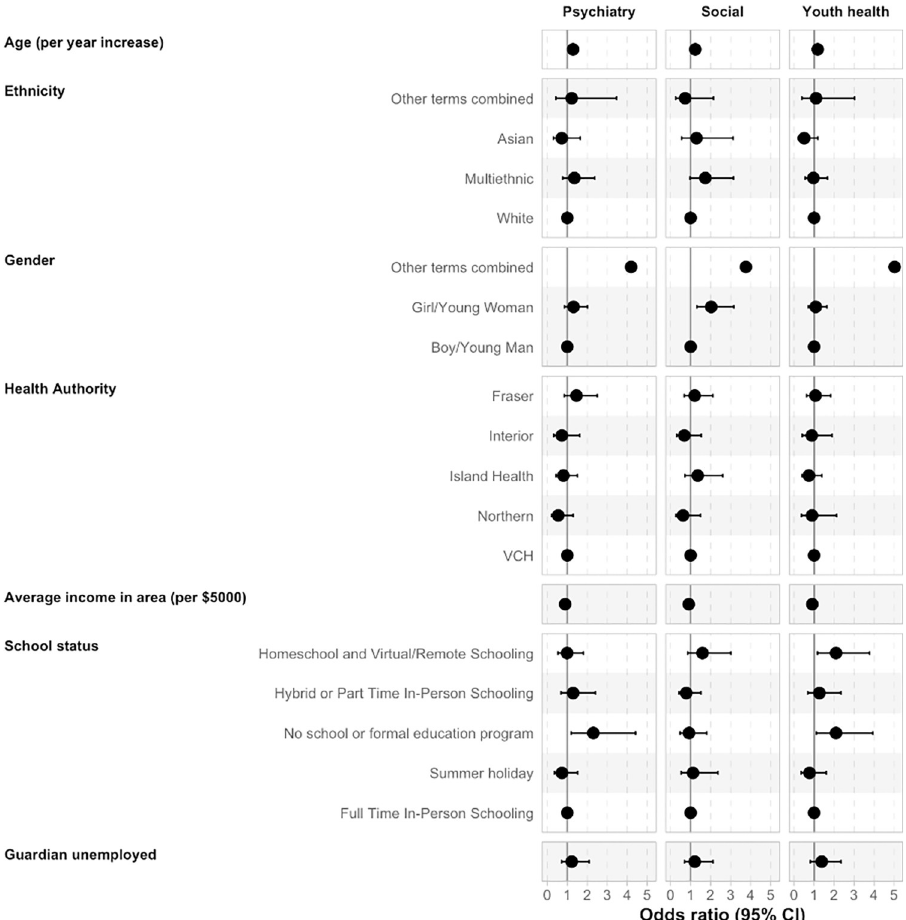
Fig 3. Results from multivariable proportional odds model indicating the odds of increased severity score (0–7) in the psychiatry, social, and youth health domains. Odds ratio and confidence interval values available in S1 File. No CI’s for age, gender-other terms combined, and average income as intervals too large for scale of